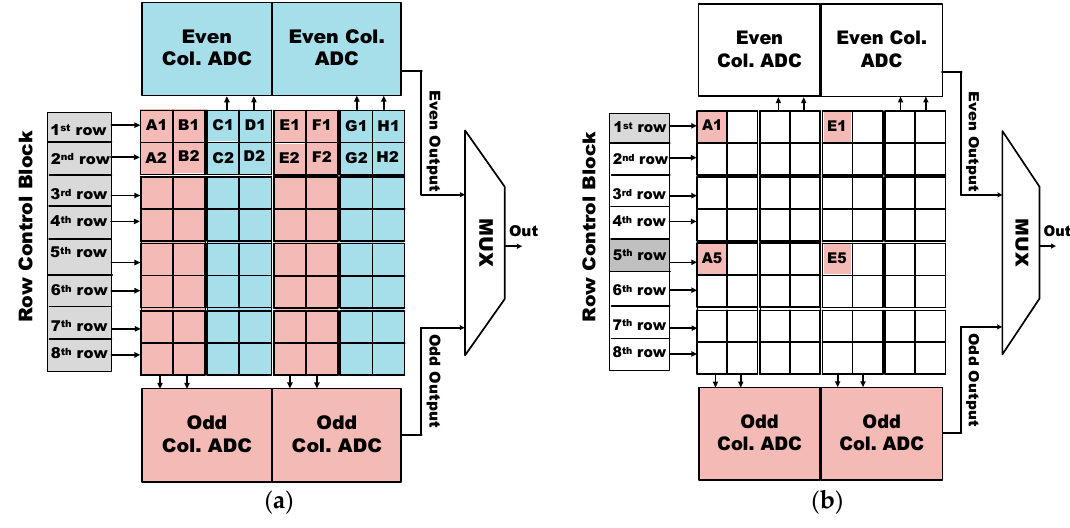
Figure 4. Simplified principle operation of multi-mode pixel resolution with 16 × 16 pixel array and ADC array for ( a ) high resolution mode and ( b ) 1/16 resolution mode.